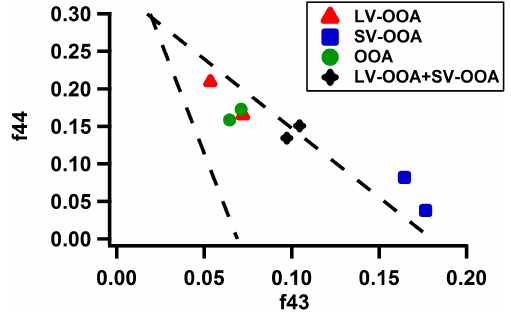
Figure 7. f44 vs. f43 plotted for each OOA factor obtained from PMF analysis of the organic fraction of HR-AMS data. OOA factors (green markers) resulted from DIAPASON2013 and POPE2013 measurements; SV-OOA (blue markers) and LV-OOA factors (red markers) were found during DIAPASON2014 and POPE2014 mea- surements. The recombination of the factors LV-OOA and SV-OOA for both DIAPASON2014 and POPE2014 is also shown (black markers). The dashed lines represent the triangular space in which measured ambient OOA components typically cluster according to Ng et al.